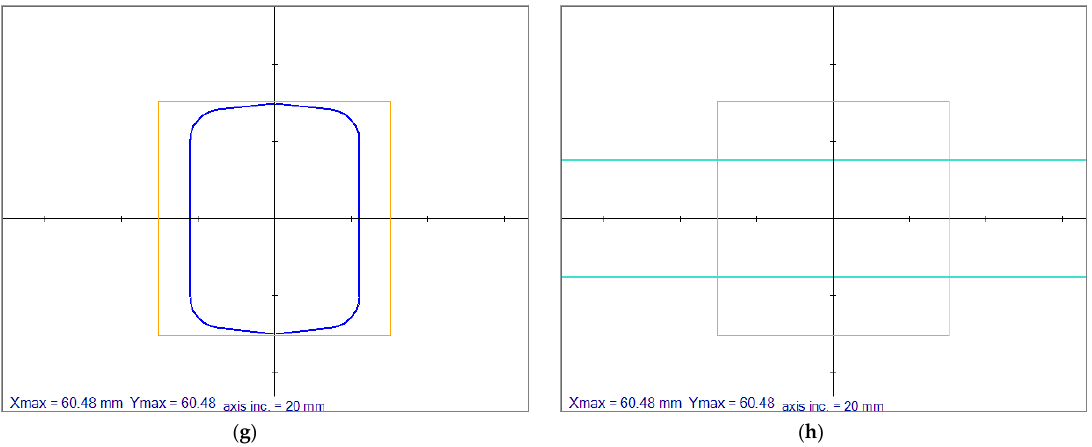
Figure 11. Demonstration of the roll shapes of each of the roll passes of an 8-roll rolling schedule. ( a ) first roll pass, ( b ) second roll pass, ( c ) third roll pass, ( d ) forth roll pass, ( e ) fifth roll pass, ( f ) sixth roll pass, ( g ) seventh roll pass, ( h ) eighth roll pass. Axis inc. is the length of axis increments.